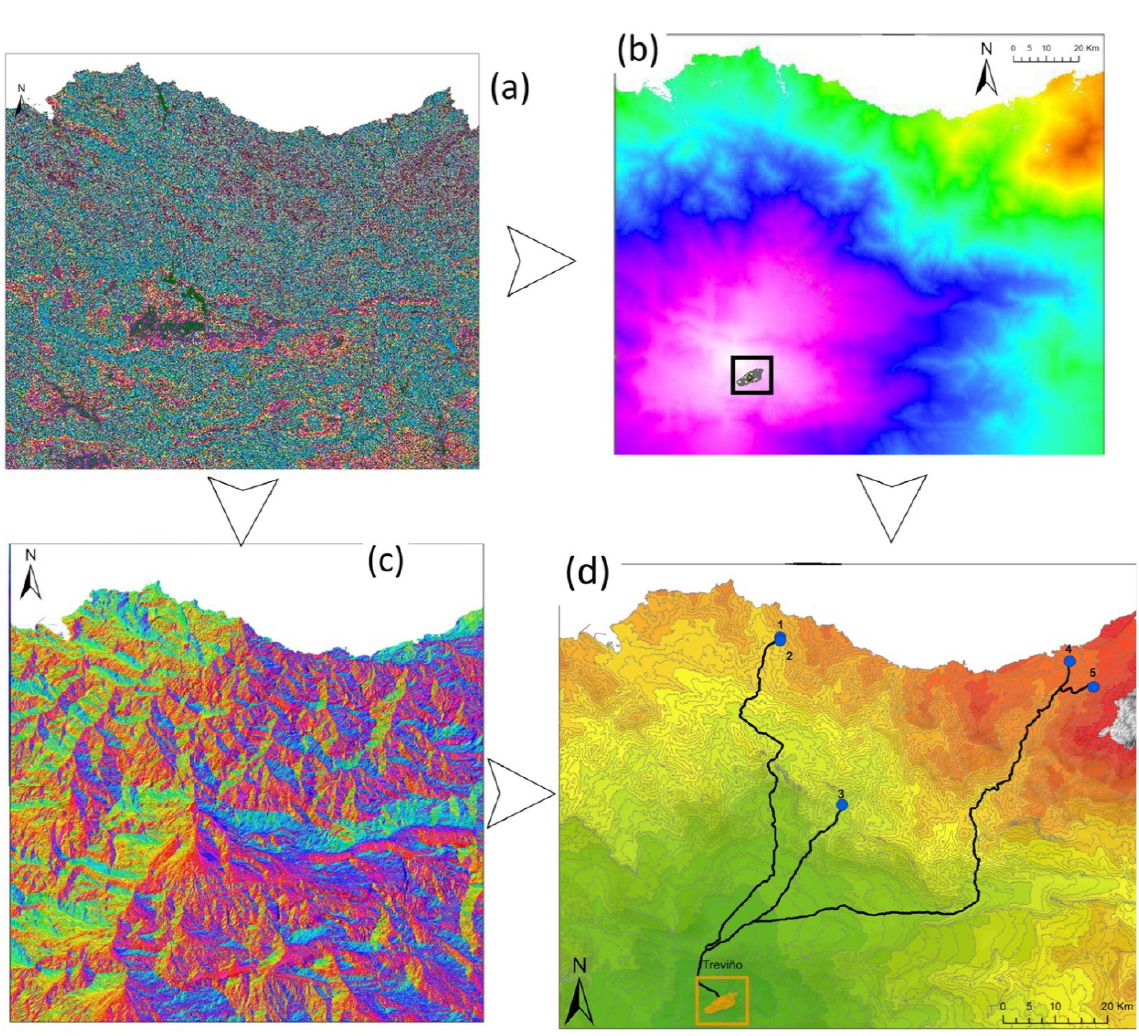
Figure 4. Methodological diagram showing the procedure for getting optimal routes and its comparison with CU and Euclidean distance: a) slope map reclassified according to the reclassification curve; b) accumulated cost map from the outcrop of Treviño; c) movement directionality map based on the cost map; d) map integrating CU and the linear magnitudes (Euclidean distance and optimal